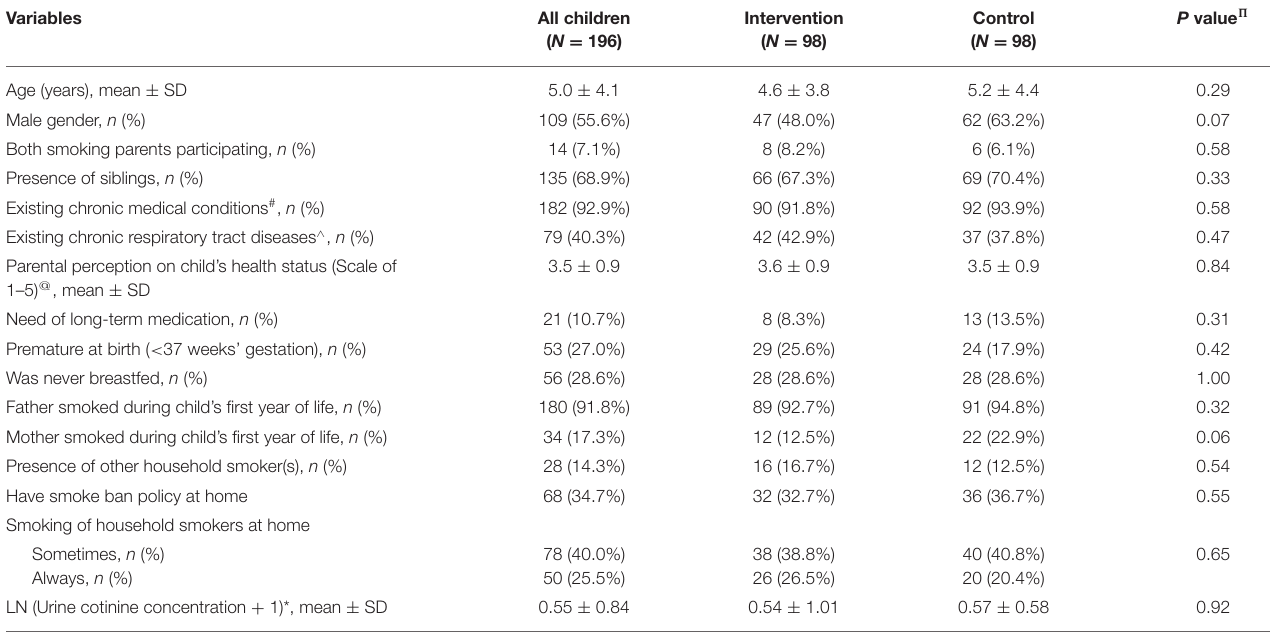
TABLE 2 | Baseline characteristics of the pediatric patients ( N = 196).